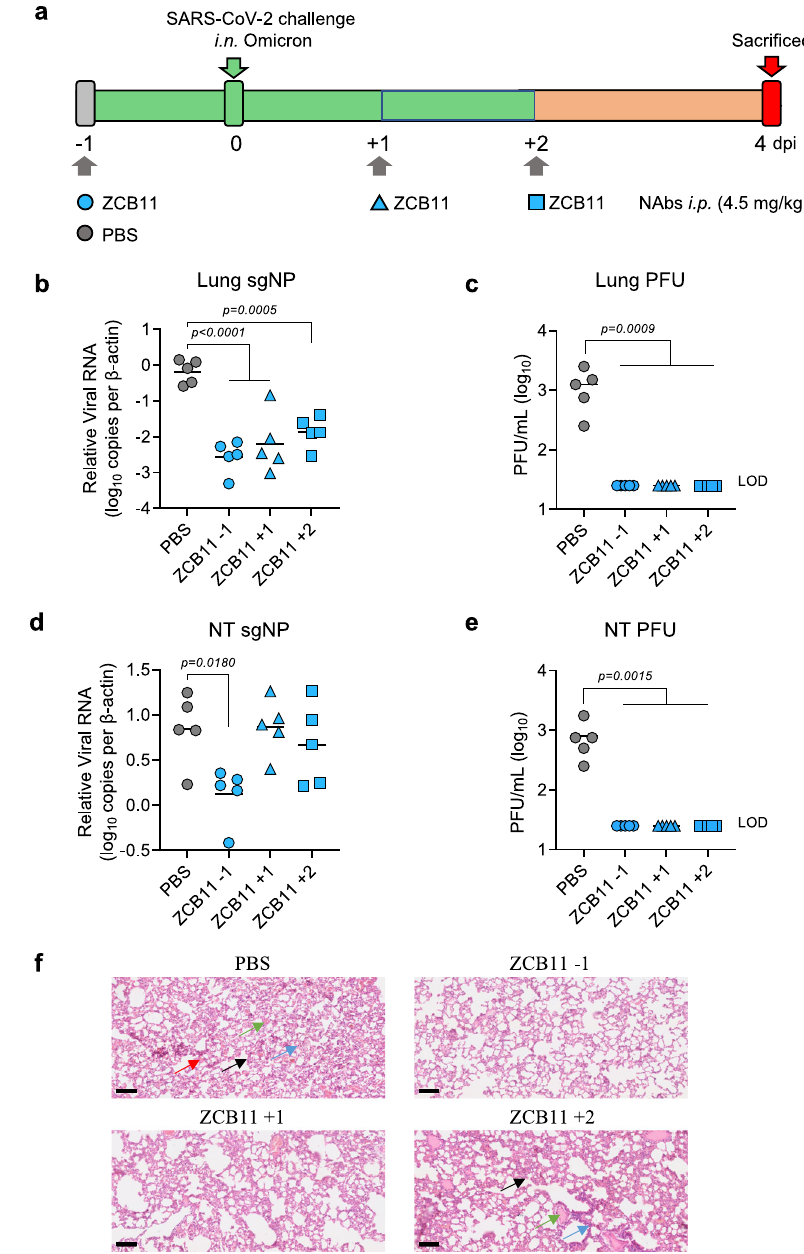
Fig. 6 Therapeutic ef fi cacy of ZCB11 against authentic SARS-CoV-2 Omicron BA.1 in golden Syrian hamsters. a Experimental schedule and color coding for different treatment groups. Two groups of female hamsters ( n = 5) received a single intraperitoneal injection of PBS (gray) or 4.5 mg/kg of ZCB11 (blue circle) at one day before viral infection ( − 1 dpi). 24 h later (day 0), all four groups of female hamsters were intranasally challenged with 10 5 PFU live SARS- CoV-2 Omicron BA.1. The other two groups of female hamsters ( n = 5) received a single intraperitoneal treatment of ZCB11 at 1 dpi (blue triangle) or 2 dpi (blue square), respectively. All animals were sacri fi ced on day 4 for fi nal analysis. b , d The NP subgenomic RNA copy numbers (normalized by β -actin) in lung and NT homogenates of each group ( n = 5) were determined by a sensitive RT-PCR. The detection of viral load was performed in at least triplicates. c , e Live viral plaque assay was used to quantify the number of infectious viruses in lung and NT homogenates. Log10-transformed PFU per mL were shown for each group ( n = 5). The dash line indicates the limit of detection. f Representative histopathology of the lung tissues from treated female hamsters ( n = 5) after viral challenge. Tissue sections were stained with hematoxylin and eosin (H&E). In the PBS-treated group and late ZCB11 treatment group (2 dpi), lung damages showed alveolar septa thickening (black arrow), some in fl ammatory cell in fi ltration (blue arrow), homogeneously pink foci of edema (green arrow) and multifocal hemorrhage (red arrow). The scale bar represents 100 μ m. PFU plaque-forming unit, SEM standard error of the mean, NP nucleocapsid protein, NT nasal turbinate, LOD limit of detection. Each symbol represents an individual hamster with a line indicating the mean of each group. The color coding was consistently used in each graph. Statistics were generated using one-way ANOVA followed by Tukey ’ s multiple comparisons test. P -values were shown on each graph where necessary. Source data ( b – e ) are provided as a Source Data fi le.